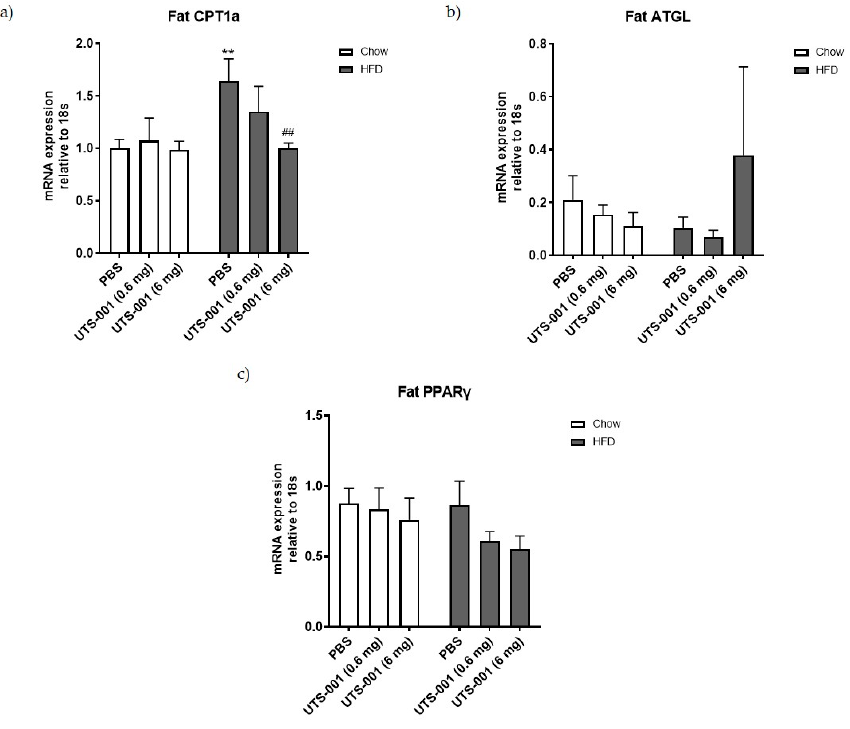
Figure 5. mRNA expression of ( a ) CPT-1a; ( b ) ATGL; ( c ) PPAR γ in the fat. Results are expressed